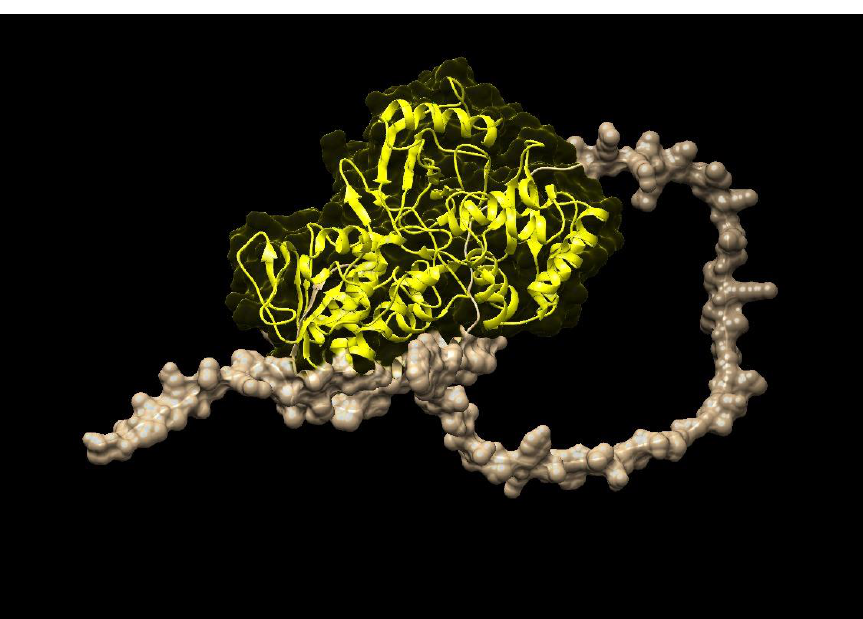
Figure 3. Three-dimensional structure of M. oleifera phytoene synthase (PSY).